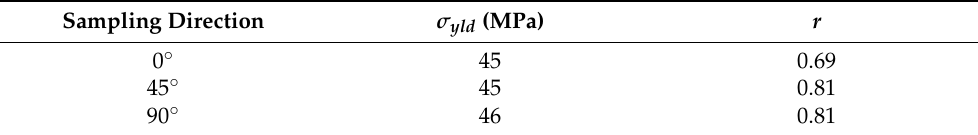
Table 2. Anisotropy coefficient ( r ) and yield strength ( σ yld ) at 400 °C. Sampling Direction